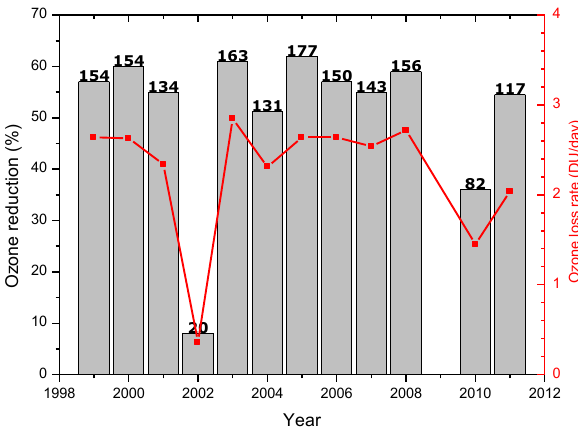
Fig. 4. Time series of ozone loss rate during phase II (red line and right scale) for the total ozone column and ozone reduction with respect to ozone in August in percent (left scale). The total amount of ozone depleted (DU) is shown at the top of the bars. In 2009 not enough sondes reached the minimum altitude to evaluate the total ozone column, so the ozone loss rate for this year is not available.